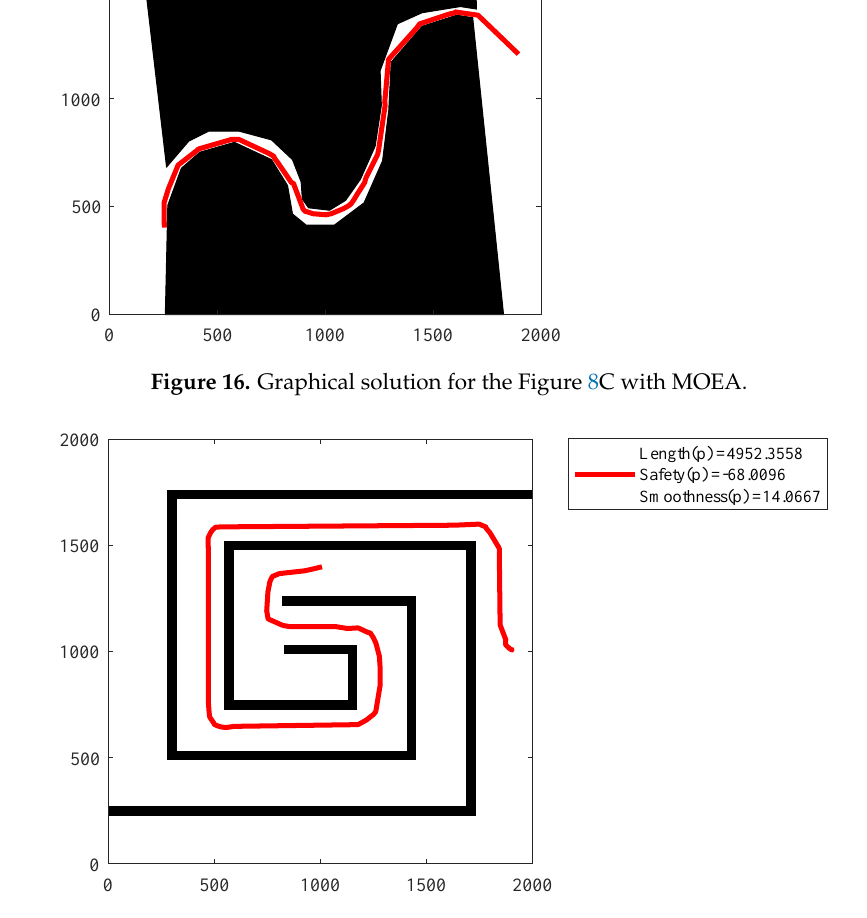
Figure 17. Graphical solution for the Figure 8D with